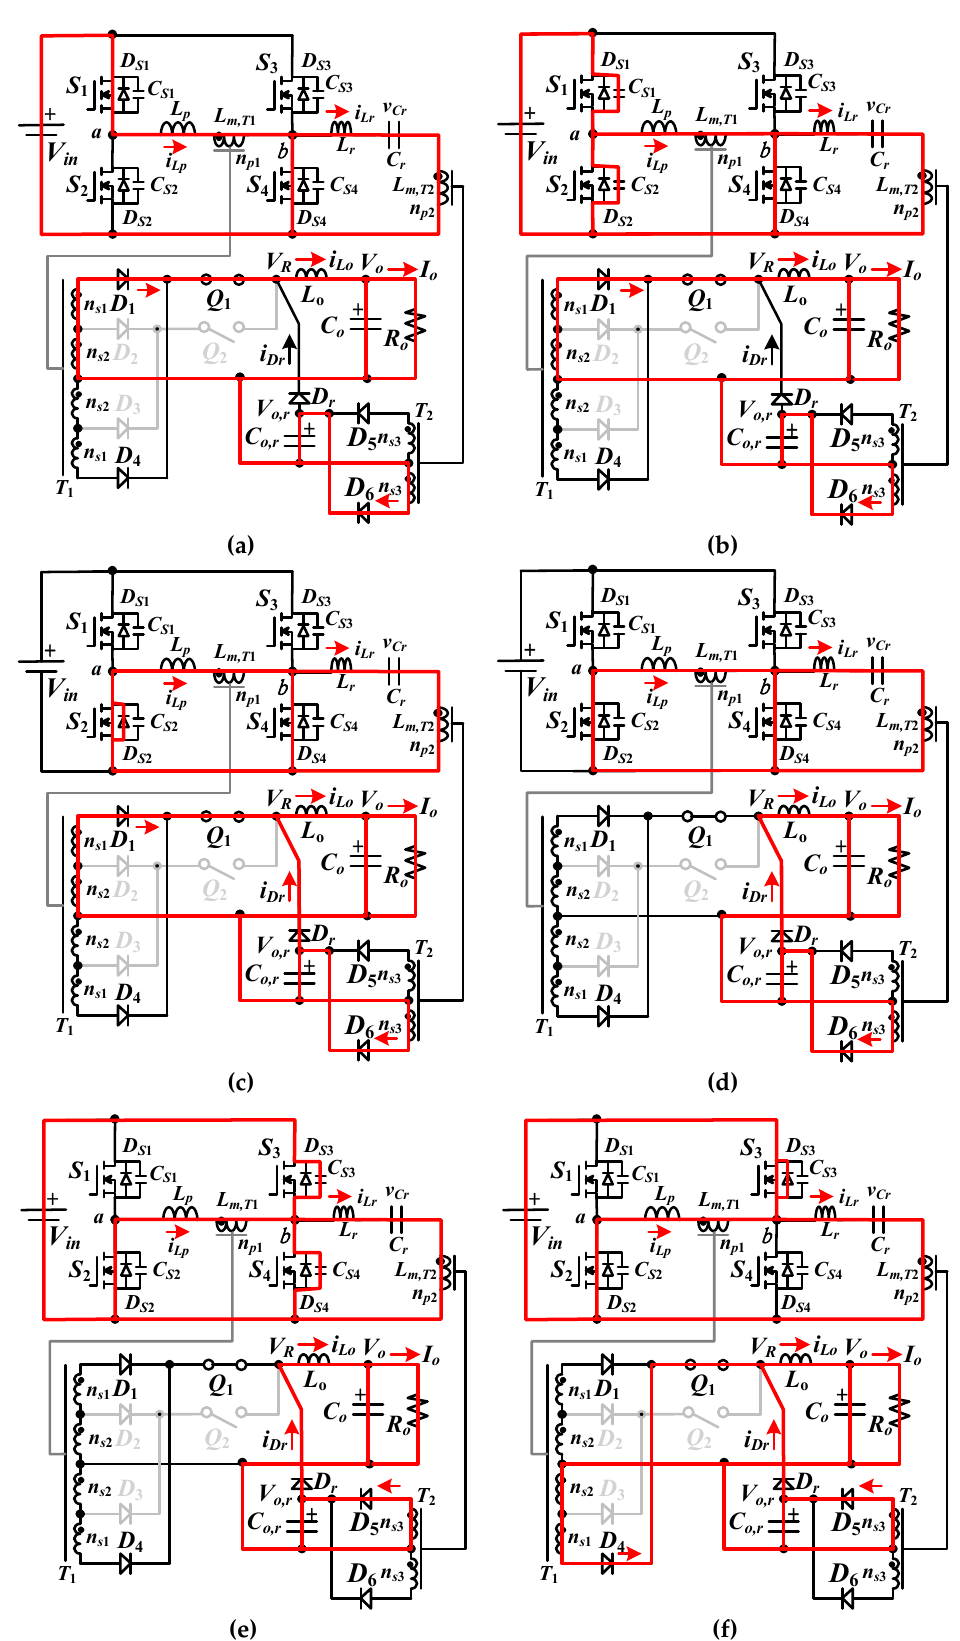
Figure 3. State circuits of the first half switching cycle under low voltage input operation ( a ) state 1 circuit ( a ) state 1 ( b ) state 2 ( c ) state 3 ( d ) state 4 ( e ) state 5 ( f ) state 6.